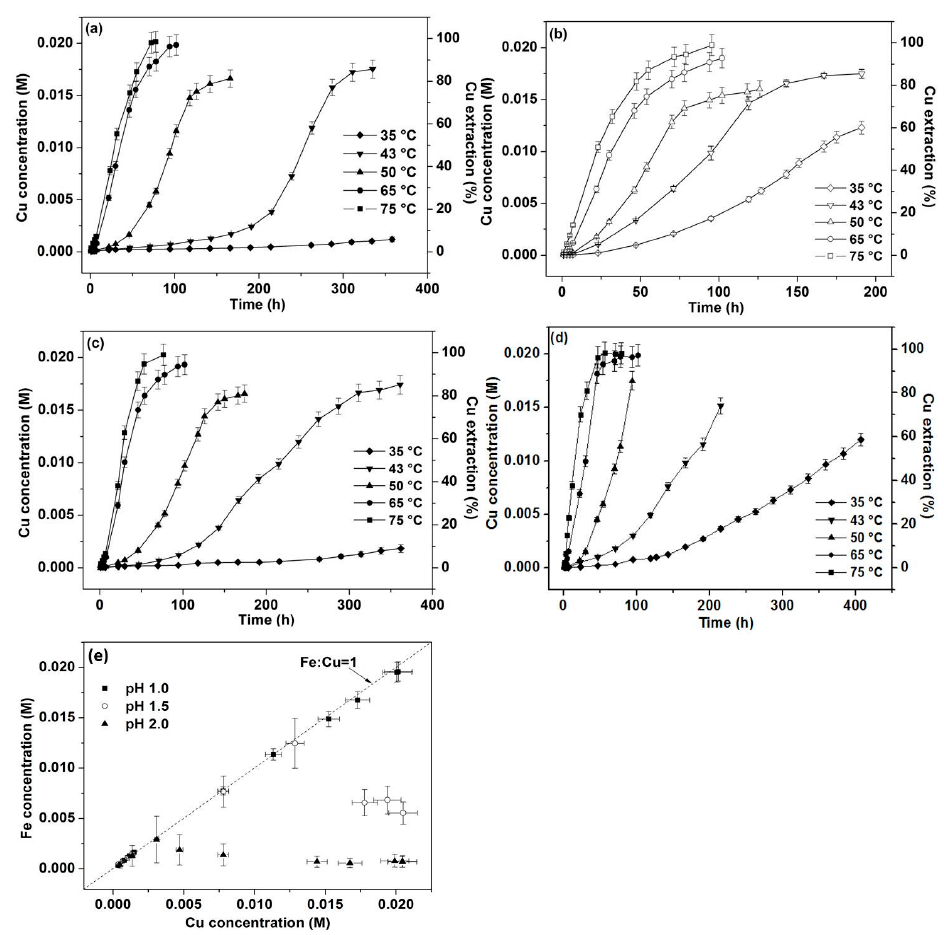
Figure 1. Cu concentrations and % extraction versus time for leaching experiments at 750 mV at 35, 43, 50, 65 and 75 °C: ( a ) pH 1.0, no iron addition; ( b ) pH 1.0 with 4 mmol iron addition; ( c ) pH 1.5,